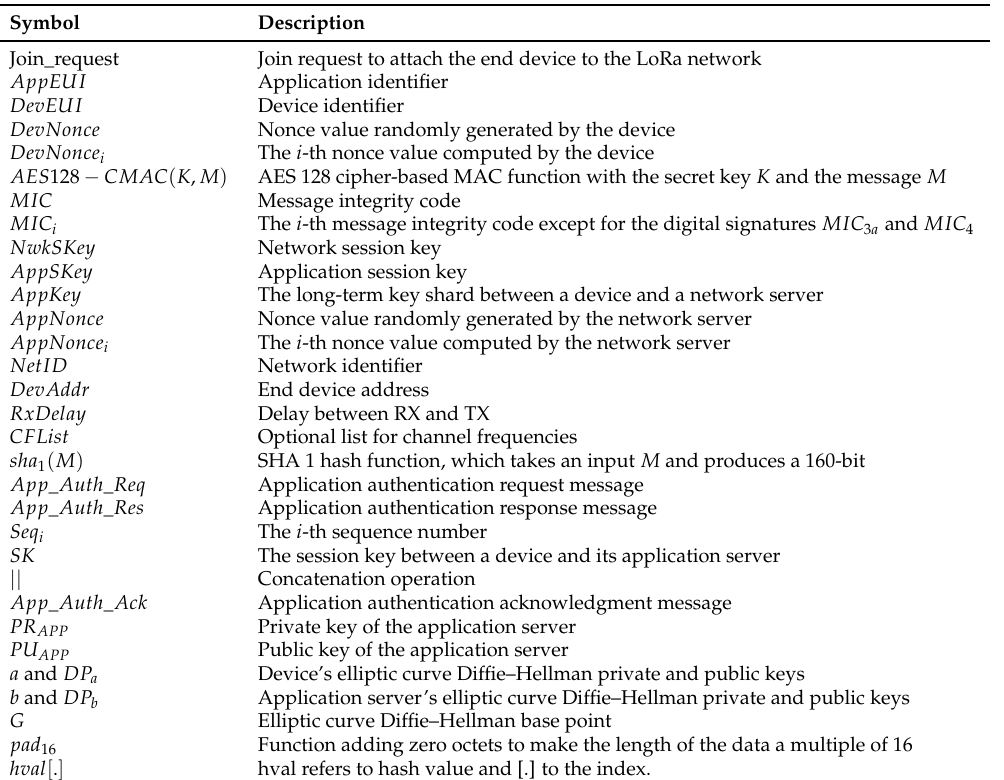
Table 1. Notations